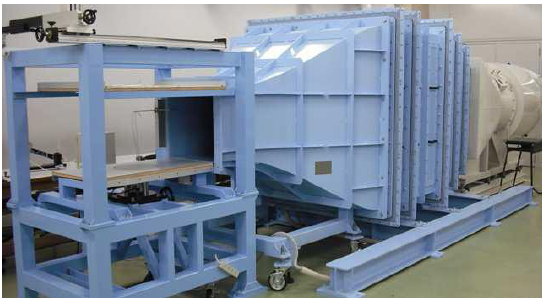
Fig. 1. Low speed wind tunnel at Kanazawa Institute of